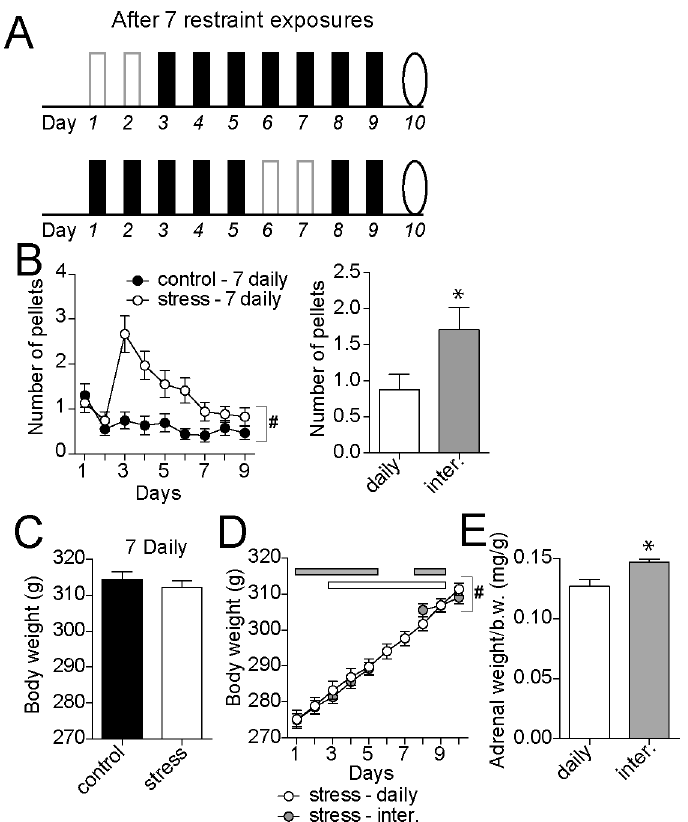
Figure 4. Interrupted stress has greater impact even when number of stress exposures is constant. A) It is possible that the diminished habituation after the interruption is due to a smaller total number of stress exposures. To test this, the interrupted stress pattern with 7 exposures (bottom) was compared to a daily stress pattern with 7 exposures (top). Solid bars represent stress exposure, open bars represent no stress, and oval represents the test day. B) There was significantly greater number of pellets over the course of 7 daily restraint episodes compared to their control (left) and a greater number of pellets one the final day of restraint in the 7 day interrupted pattern compared to the 7 daily pattern (right). C) The body weight at the end of the course of 7 daily pattern was not significantly different between the control andd stress group. D) The body weight of the 7 daily stress group was not significantly different than the interrupted stress group after the final episode. However, there was a significant interaction between body weight and treatment over the course of stress exposures, consistent with a difference in the pattern of weight gain. E) Adrenal gland weight (normalized to body weight) was significantly greater in the interrupted stress group compared to the equi-numbered daily restraint group. * indicates p , 0.05 in post hoc comparisons after Bonferroni corrections (B, left; E). # indicates significant Pattern x Day interaction